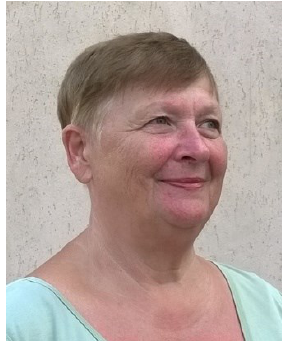
Figure 2. Antonina Sopińska joined the Institute of Biological Bases of Animal Diseases, Subdepartment of Fish Diseases and Biology, University of Life Sciences, Lublin (Poland) in 1973. She received her DSc (“Habilitation”) degree based upon a thesis entitled “The effect of immunostimulation on cellular defense under different conditions in carp” in 1991.